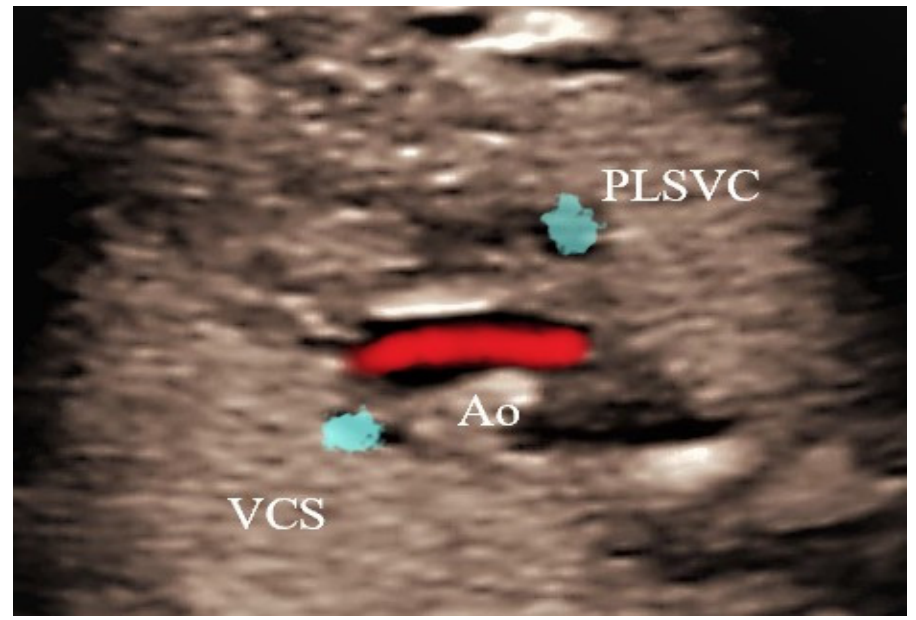
Figure 4. Transversal section superior to the TTVV—absence of the innominate vein. PLSVC—per-